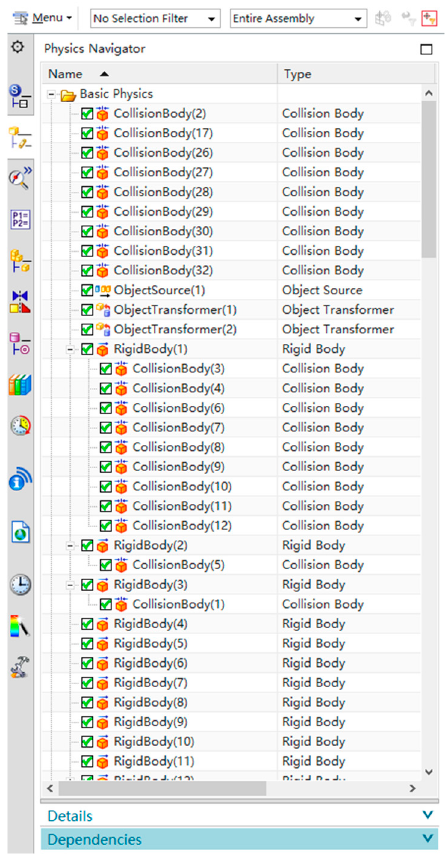
Figure 6. The definitions of collision body and rigid